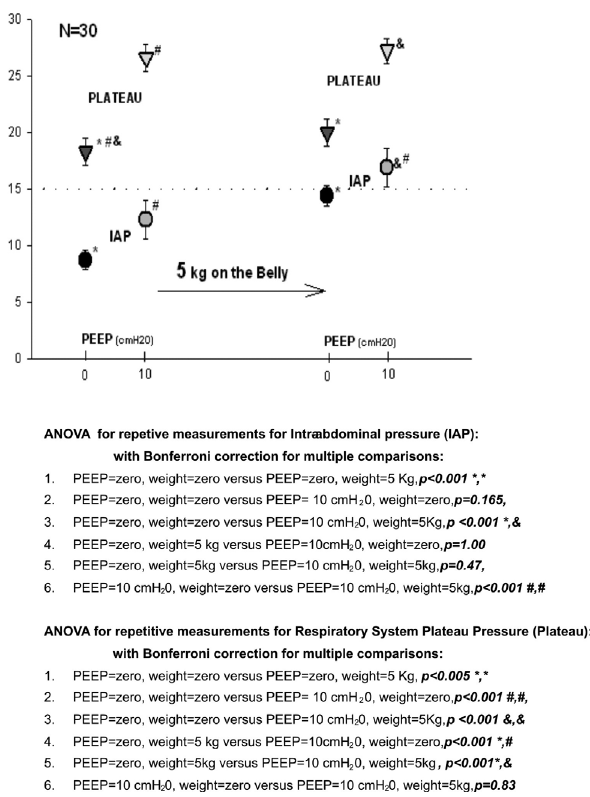
Figure 2 - Changes in intra-abdominal and respiratory system plateau pres- sure with PEEP and external abdominal weight